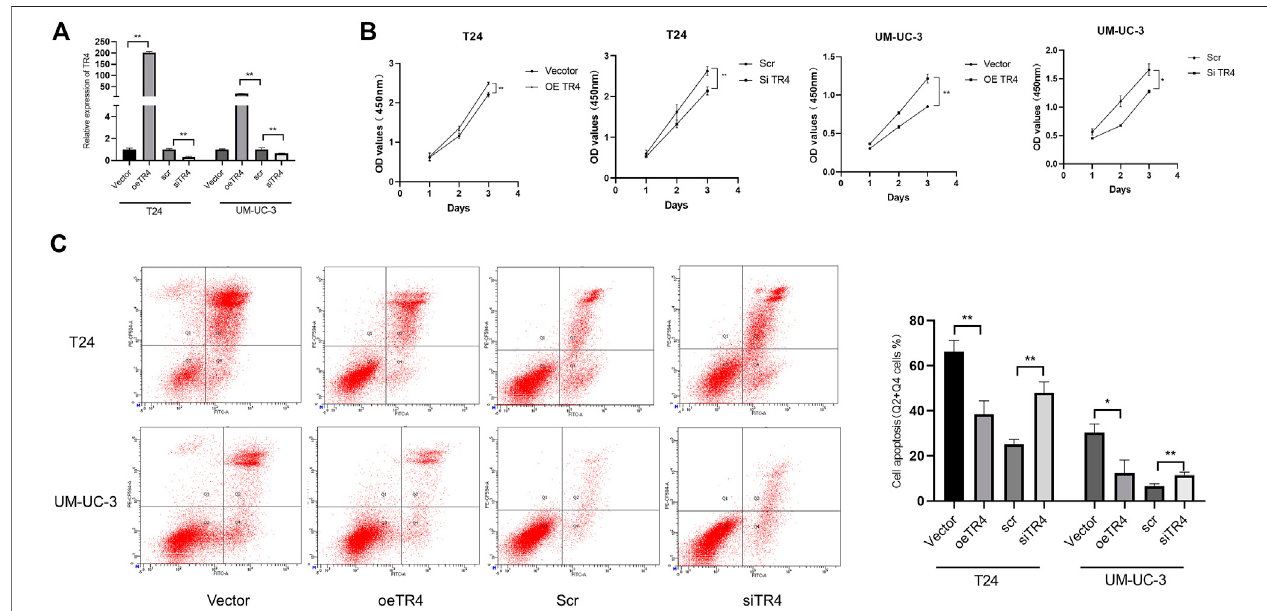
FIGURE 2 | Effect of TR4 on proliferation and apoptosis in BC cell lines: (A) Relative TR4 mRNA expression was measured via qPCR after transfecting Vector, oeTR4, scr, and siTR4 in BC cell lines, including T24 and UM-UC-3. GAPDH was used as the internal control, ** p < 0.05. (B) Vector, oeTR4, scr, and siTR4 were transfectedtotheT24andUM-UC-3cells.Therelativecellviabilitywasmeasuredat24,48,and72 h via theCCK8assay,* p < 0.05,** p < 0.01. (C) Flowcytometryassay was used to evaluate the apoptosis analysis after transfecting Vector, oeTR4, scr, and siTR4, * p < 0.05, ** p < 0.01.